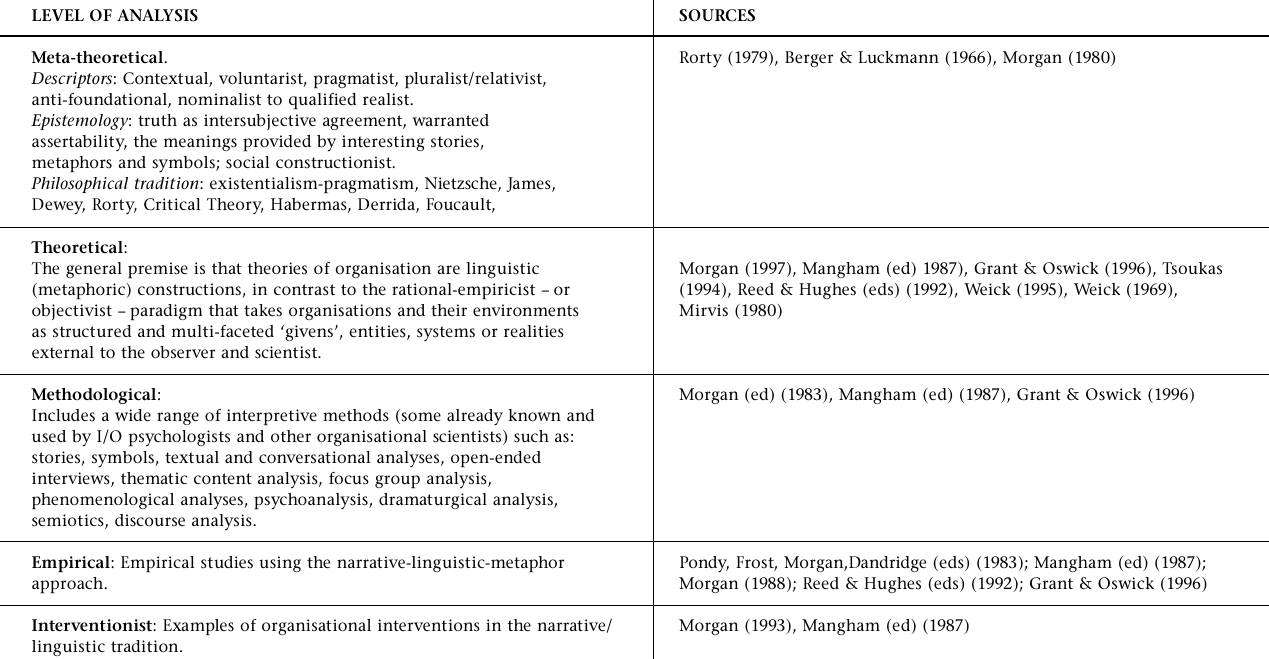
Figure 5: A multi-level outline of narrative-interpretive (type III)